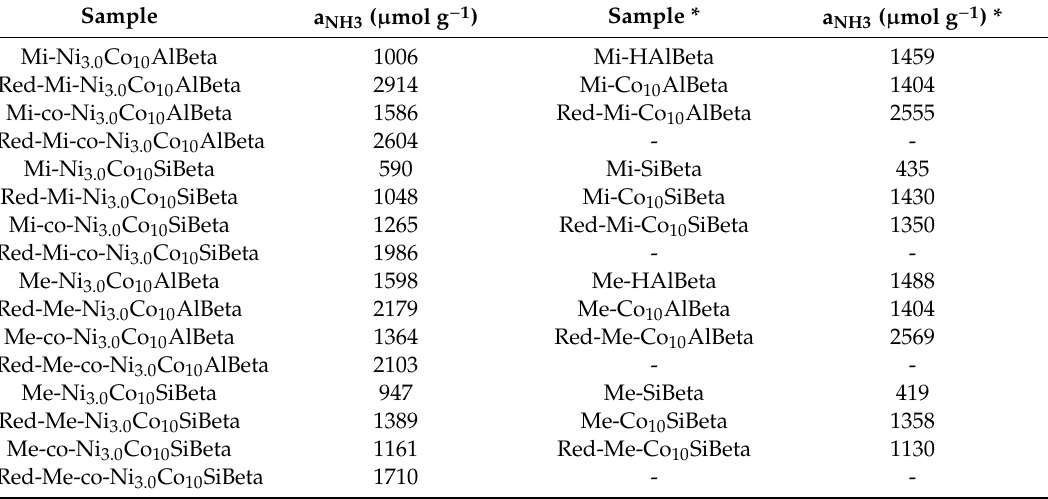
Table 2. The quantitative data of NH 3 -TPD for reduced and non-reduced Ni 3.0 Co 10 Beta systems.